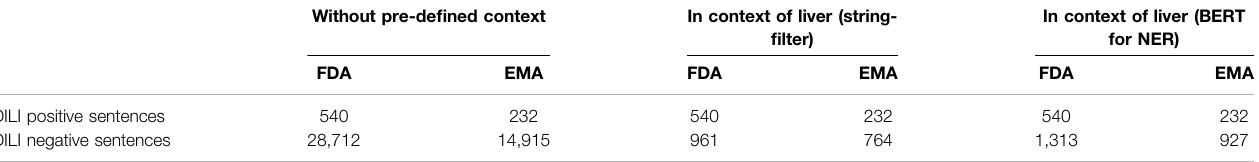
TABLE 1 | Sentence count with or without pre-de fi ned liver-related